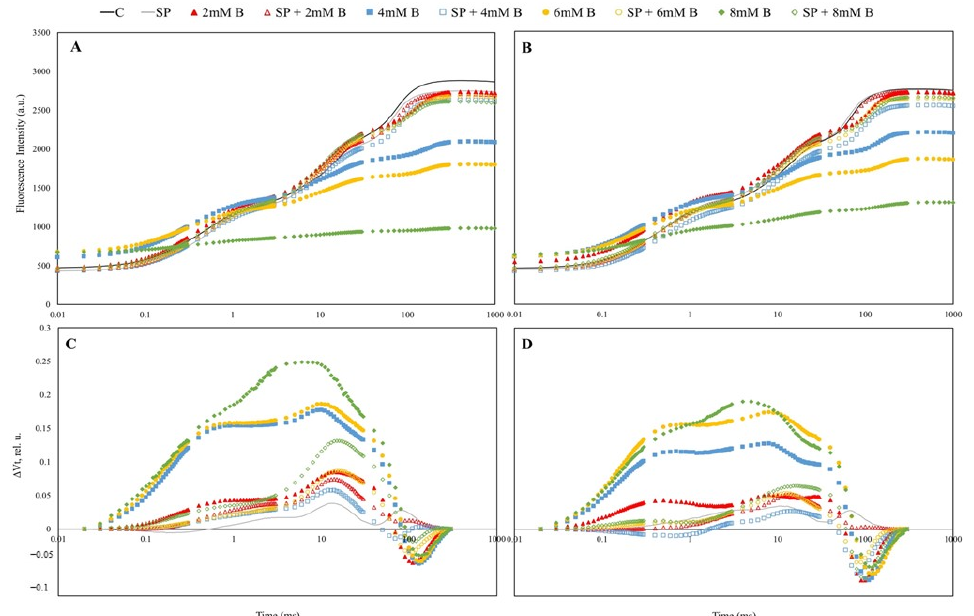
Figure 3. Induction curves of polyphasic ChlF and differential curves of the relative variable fluo- rescence ( Δ V t ) of safflower cultivars submitted to toxic B with or without SP ( A , C , Dinçer; B , D , Remzibey-05, respectively). The transients are plotted on a logarithmic time scale (10 µs to 1 s). The mean values are plotted, n = 6.